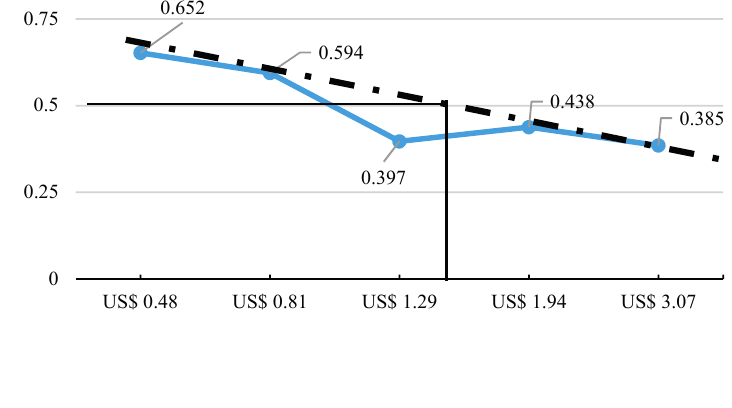
Figure 3. Respondents’ 50% acceptance of the proposed HKWS services (n = 327).